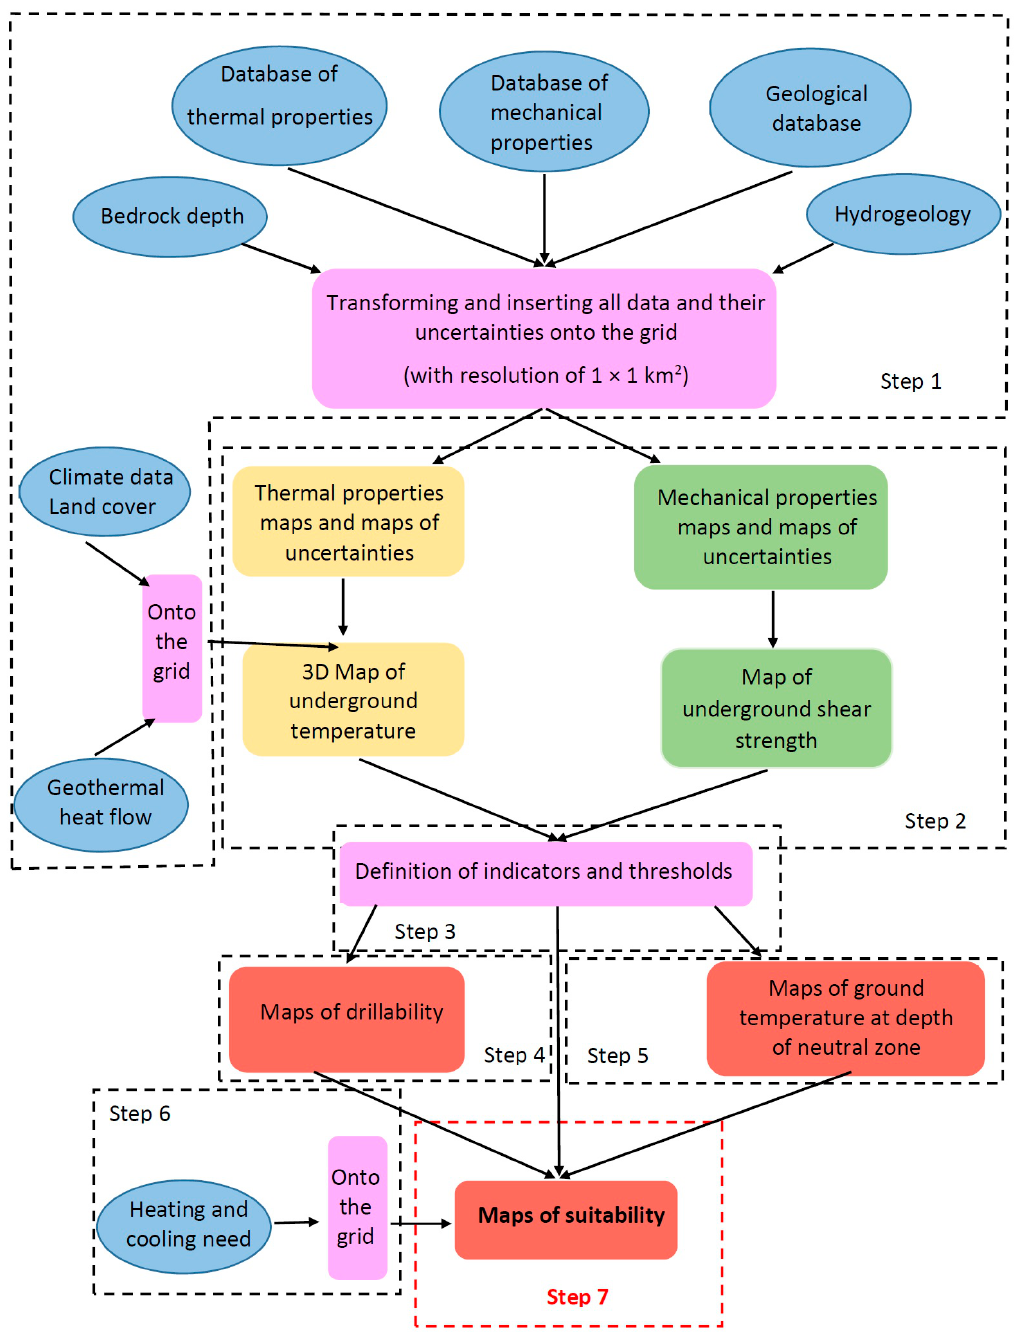
Figure 1. Workflow of the methodology developed within the GEOTeCH project to provide a suitability assessment of the technologies